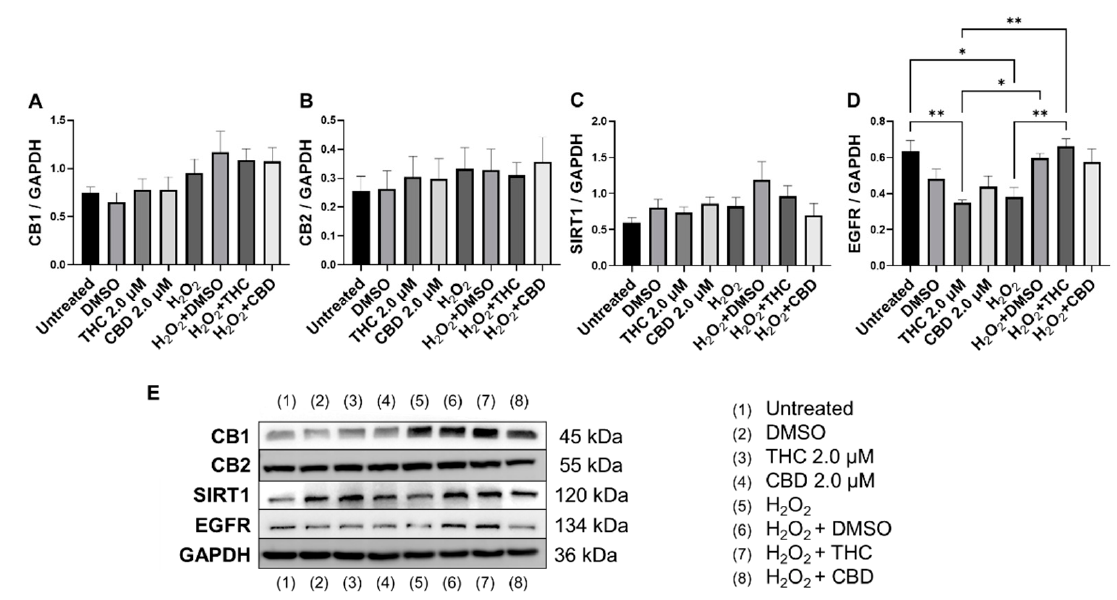
Figure 11. Effects of phytocannabinoids on cannabinoid receptors and metabolic regulators in CCD- 1064 human dermal fibroblasts (PDL 24). Relative densitometry was presented as a ratio of the target protein relative to GAPDH for expression of ( A ) CB1, ( B ) CB2, ( C ) SIRT1, and ( D ) EGFR, ( E ) representative images blots with each protein detected. Original membranes can be seen in Figures S21–S25. Data were analyzed with an ANOVA test followed by Tukey’s post-hoc multiple comparison test. Bars represent mean ± SEM, n = 3. Significance is indicated using the following scale: * p < 0.05, ** p < 0.01. CBD, cannabidiol; DMSO, dimethyl sulfoxide (vehicle); THC, delta-9-tetrahydrocanna- binol.